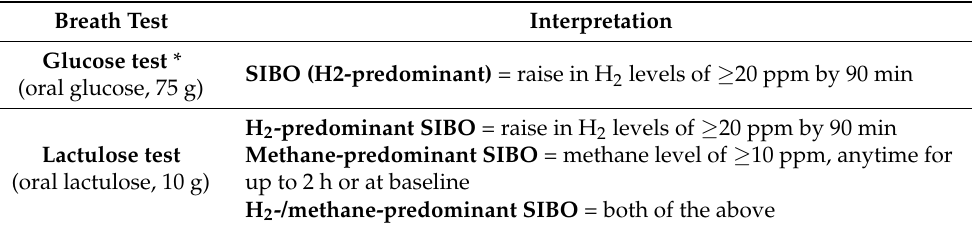
Table 1. Carbohydrate breath tests for